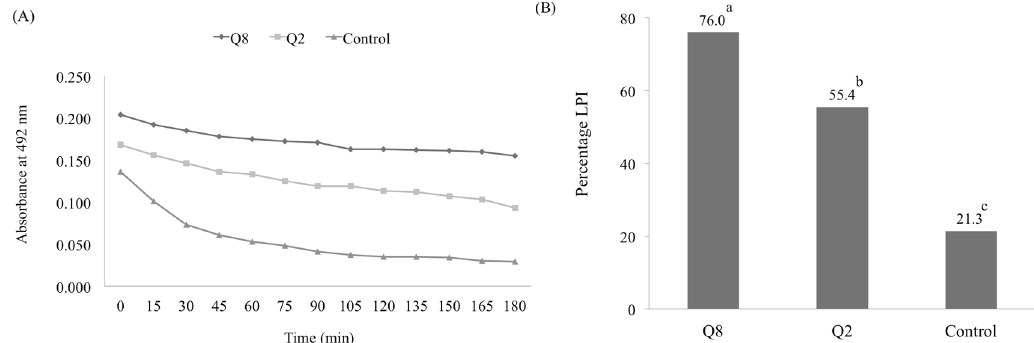
Figure 5. Antioxidant activities of phenolic extracts of Q8 and Q2 measured by β -carotene bleaching method ( A ) and lipid peroxidation inhibition (% LPI) ( B ). Means that do not share a letter are significantly different ( p = 0.05).